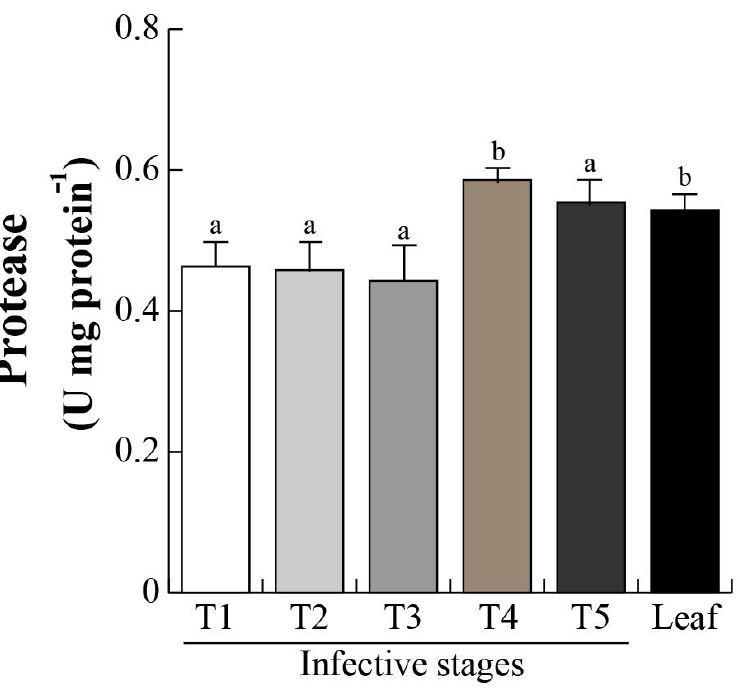
Figure 6. Protease activity of infective stages. Protease activity was measured from total seed protein Figure 7. Chlorophyll content of infective stages. The pigment was extracted from each invasive extracts from P. calyculatus infective stages and leaves. Bars represent mean ± SE (n = 10), different stage. Bars represent mean ± SE (n = 10), different letters above the bars indicate significant differ- ences among infective stages ( p < 0.05 according to ANOVA and Tukey test). letters above the bars indicate significant differences among infective stages ( p < 0.05 according to ANOVA and Tukey test).